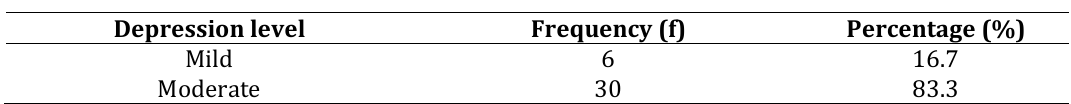
Level of depression before life-review therapy